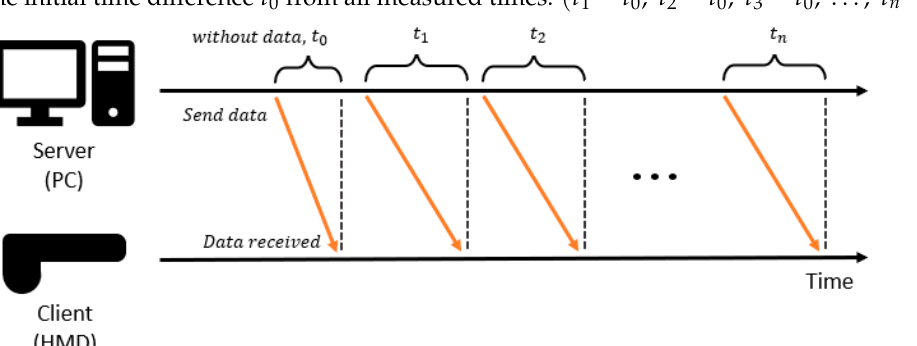
Figure 9. Measurement of latency caused by data transmission from the PC to the HMD.